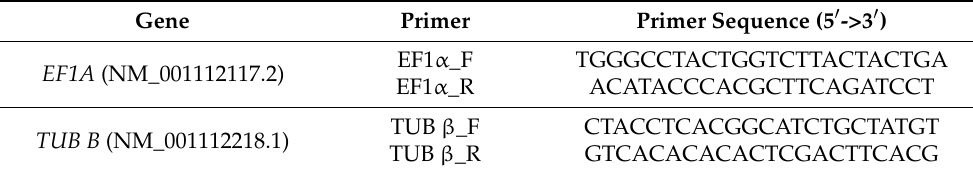
Table 3. Sequences of primers for chosen reference